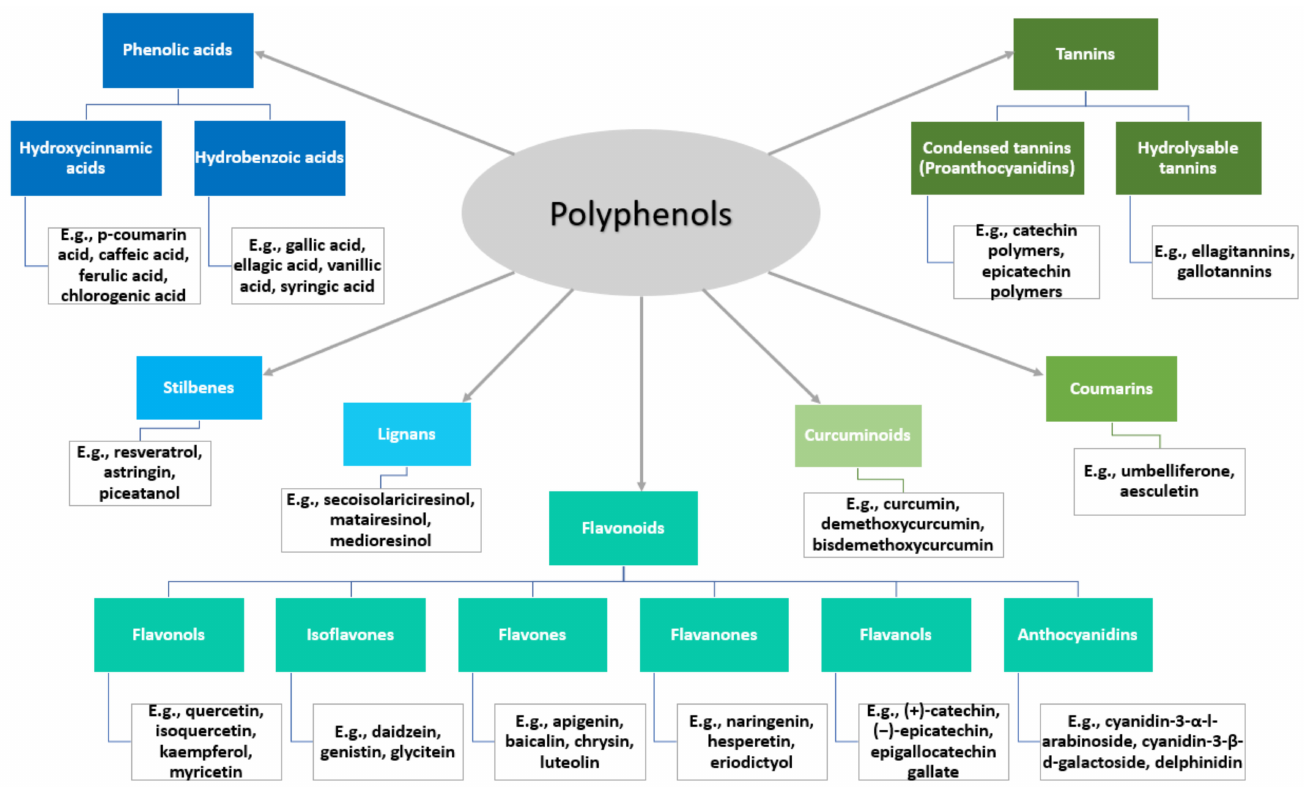
Figure 3. Polyphenols classification and examples. Created based on information from